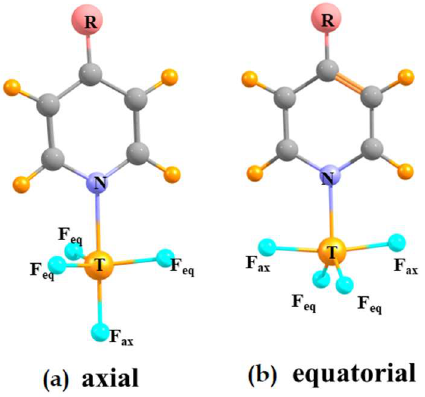
Figure 2. MP2-optimized structures of ( a ) axial and ( b ) equatorial complexes of TF 4 (T = Si, Ge, Sn) with pyridine and its derivatives (R = H, OH, CH 3 , CF 3 ). Table 2. Structural parameters (R in Å, angles in degs) of complexes at the MP2/cc-pVTZ level. Axial Complexes Equatorial